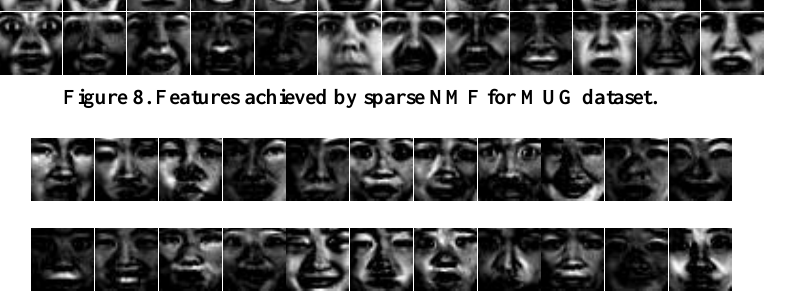
Figure 9. Features achieved by NMF for JAFFE dataset.